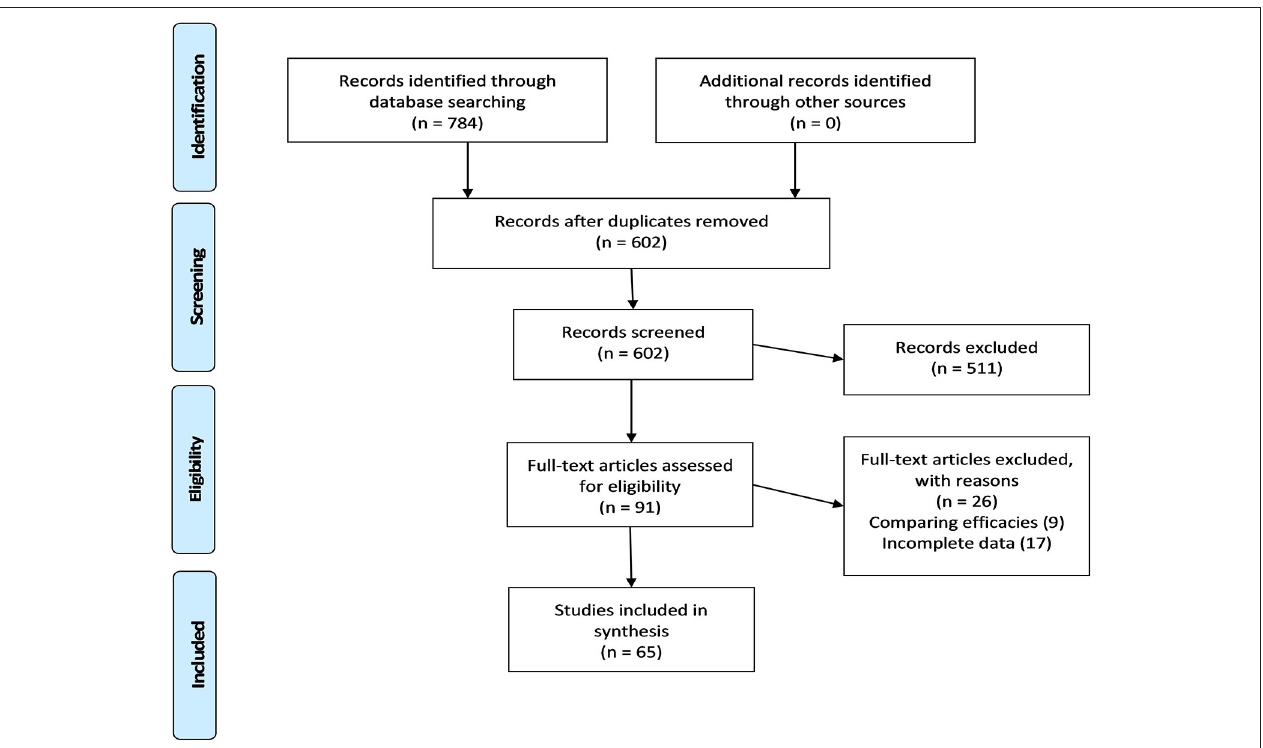
FIGURE 1 | PRISMA guidelines flow